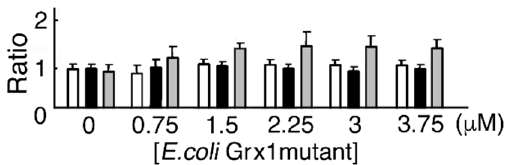
Figure 5. E. coli Grx1 mutant and GSH dose-dependent MST activation. One MST reducing system